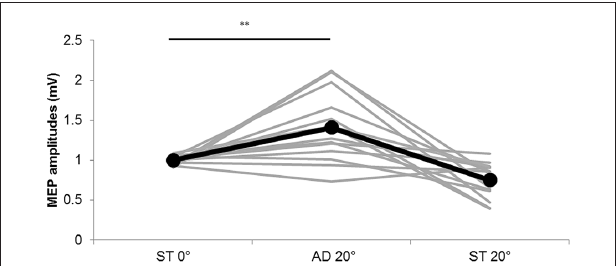
FIGURE 4 | MEP amplitudes during static and passive movement conditions in Experiment 1. The black line shows the mean MEP amplitude and gray lines the individual values in Experiment 1 at 0 ◦ static joint angle (ST 0 ◦ ), 0 ◦ joint angle during passive adduction (AD 0 ◦ ), 20 ◦ adduction during passive adduction (AD 20 ◦ ) and the same angles during abduction (AB 0 ◦ and AB 20 ◦ ). There was a significant increase in MEP amplitude at AD 0 ◦ compared with ST 0 ◦ ( ∗∗ p < 0.01).